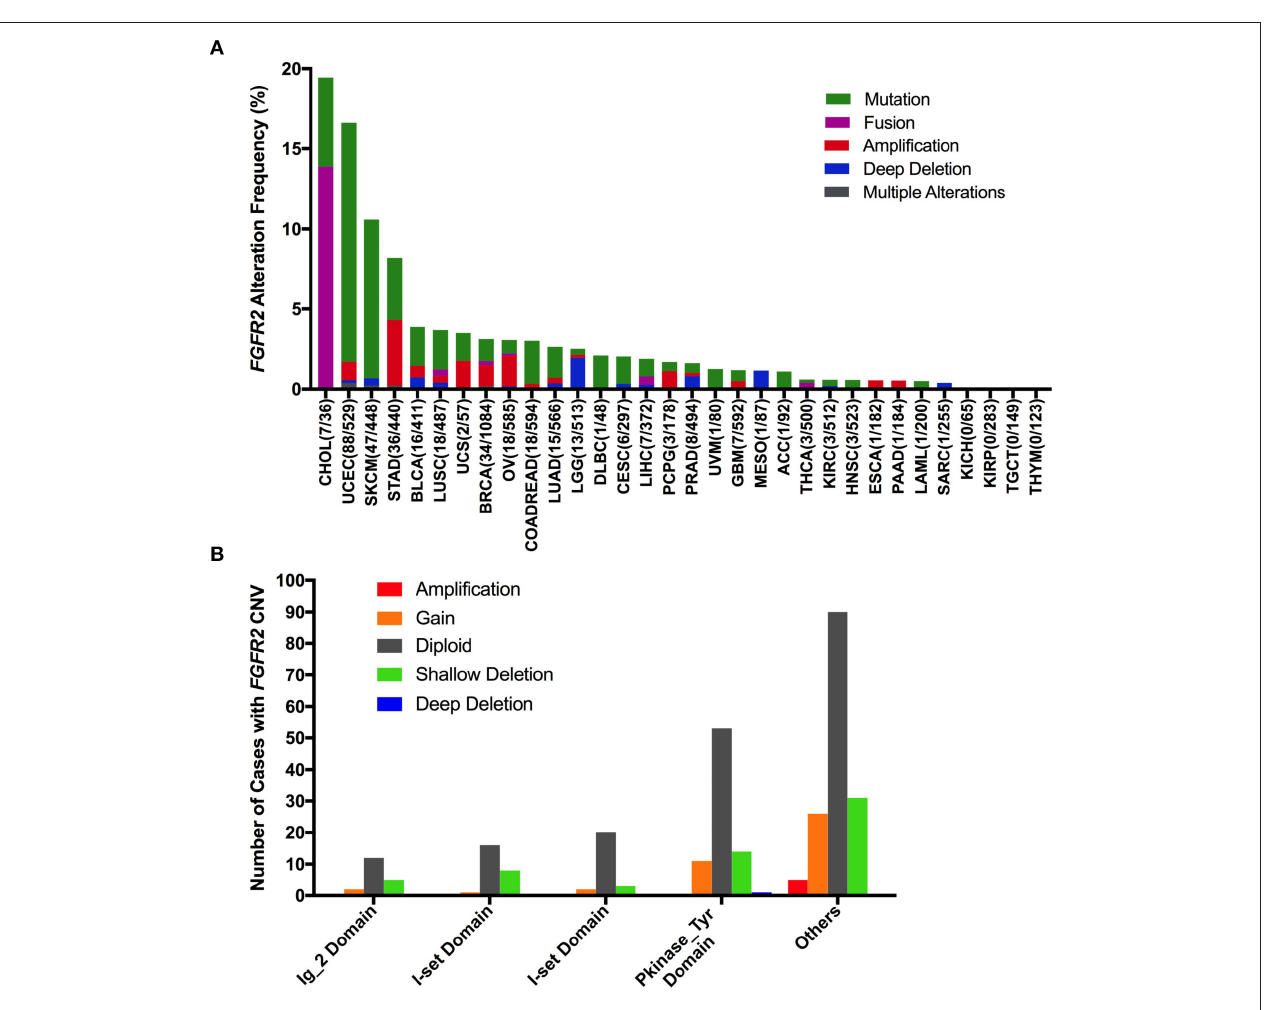
FIGURE 2 | FGFR2 alteration frequency and distribution across TCGA cancer types. (A) FGFR2 alteration (mutation and CNVs) frequency in 32 cancer types. (B) The distribution of CNV types along with mutations located in different FGFR2 functional domains. FGFR2 functional domains: Ig_2 (43–115 aa), I-set (172–248 aa), I-set (264–359 aa), and PKinase_Tyr domains (481–757 aa). aa, amino